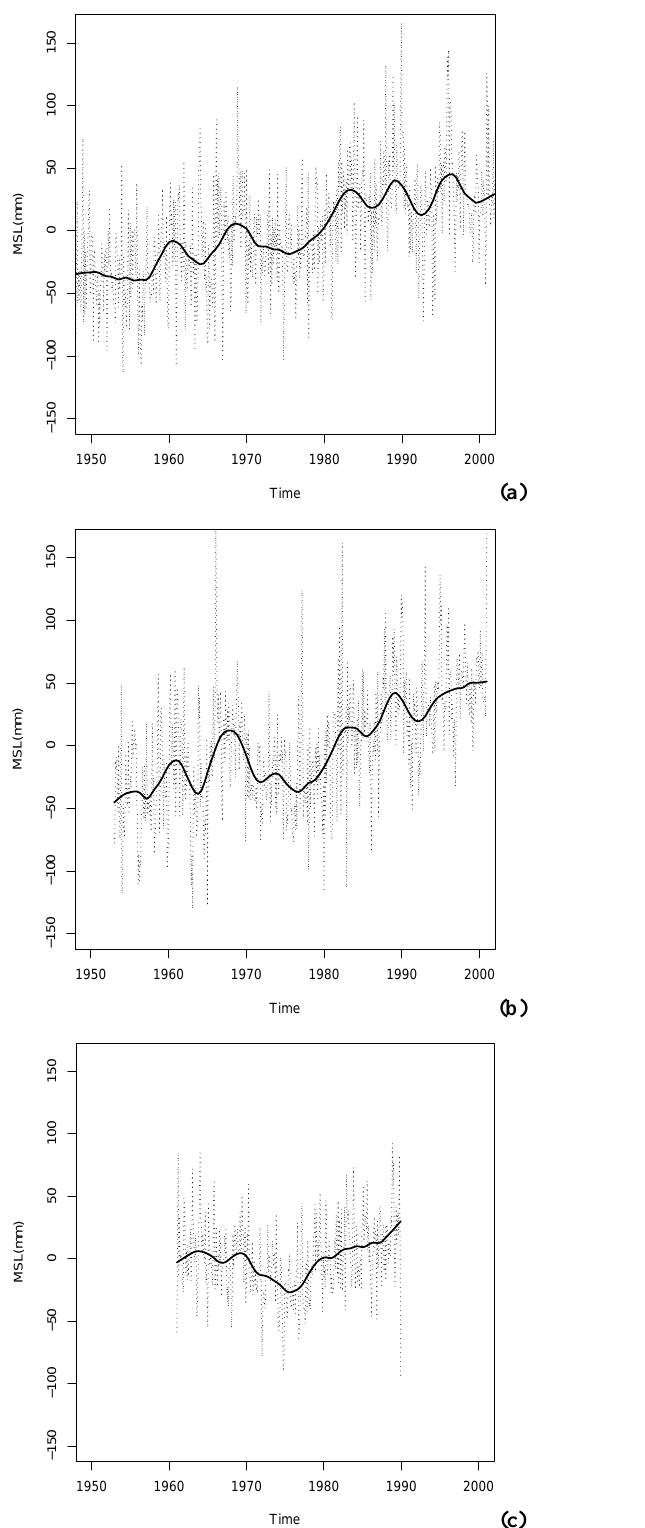
Fig. 5. Precipitation deficiency (%) at tide gauge locations for win- ter (triangles) and summer (circles), (a) Newlyn, (b) Brest and (c)